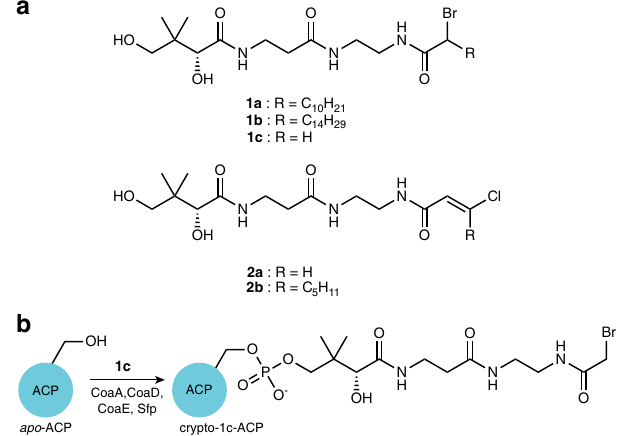
Fig. 2 KS pantetheineamide crosslinking probes and ACP one-pot method. a Pantetheineamide-derived α -bromo and chlorovinyl crosslinking probes used in this study. b An illustration of the one-pot chemoenzymatic loading of apo-ACP with panetheinamide probe 1c to produce crypto- 1c - ACP using the coenzyme A biosynthetic enzymes CoaA, CoaD, and CoaE and a promiscuous phosphopantetheinyl transferase (PPTase)